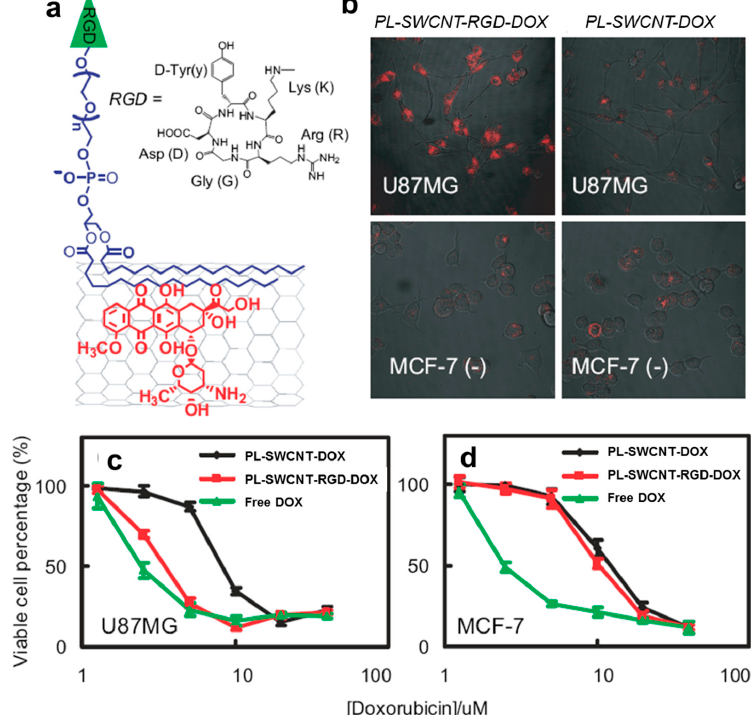
Figure 3. ( a ) Conjugation of cyclic arginine-glycine-aspartic acid (cRGD) peptide into PEG-functionalized SWCNTs (PL-SWCNT-RGD); ( b ) Immunofluorescence images of integrin α v β 3 -positive U87MG cells (top) and integrin α v β 3 -negative MCF-7 cells (bottom) with either the selective intracellular uptake of doxorubicin (DOX) via cRGD (top left) or non-specific delivery of DOX (the rest); ( c , d ) DOX dosage-dependent survival rates of U87MG cells ( c ) and MCF-7 cells ( d ) treated with various delivery vehicles as indicated. Reprinted with permission from Ref. [19]. Copyright (2016) American Chemical Society.